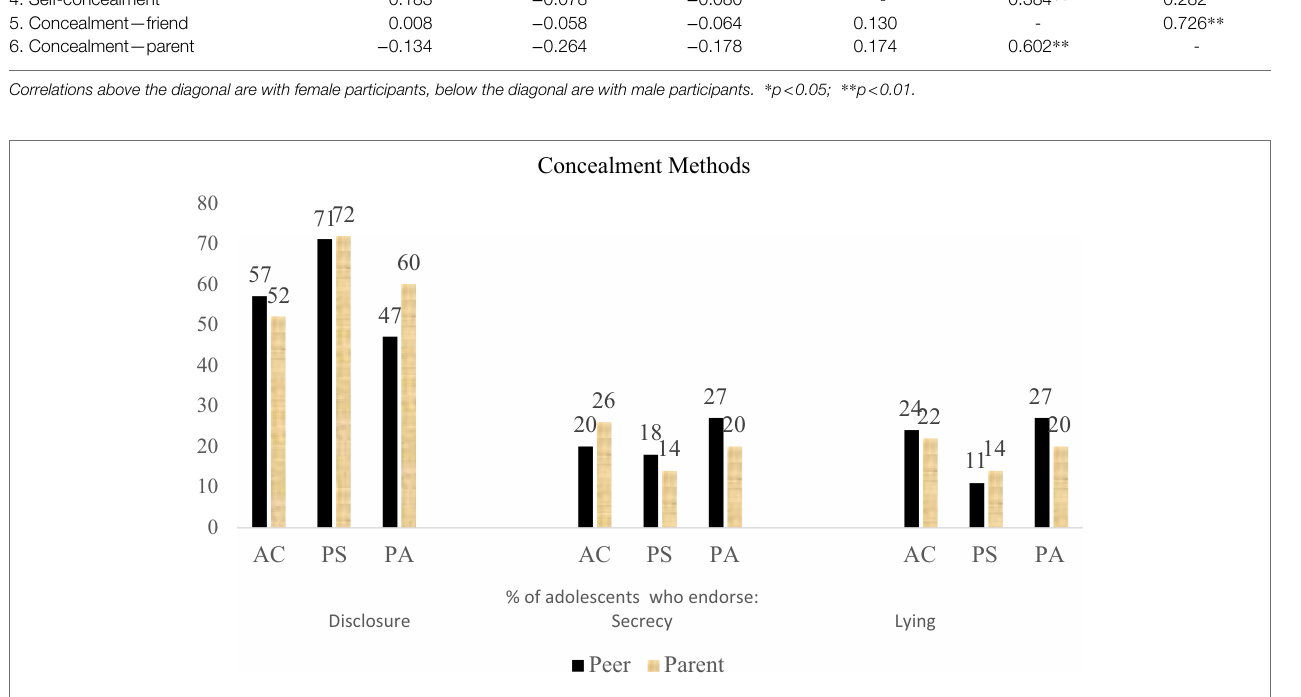
FIGURE 1 | Concealment methods endorsed (in %), according to motive for concealment and information receiver. AC, avoid consequences; PS, protect self; and PA, protect another.